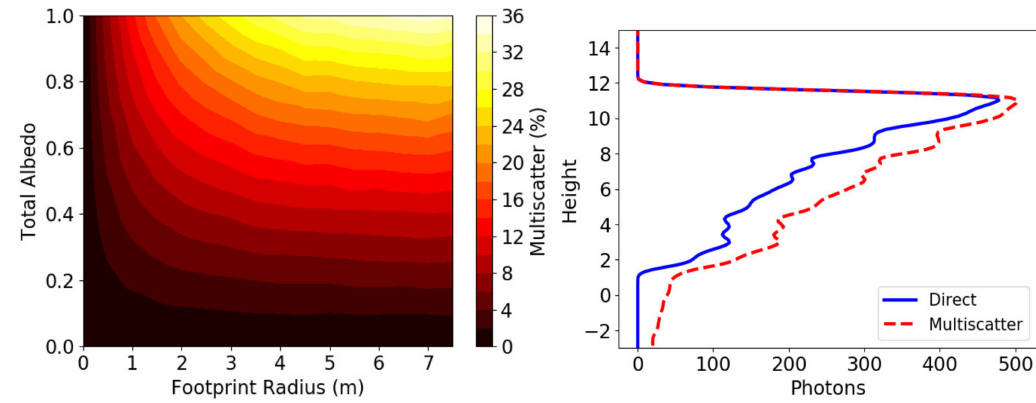
Figure 3. The left figure is the multiscatter contribution percentage as a function of lidar footprint radius and total albedo (reflectance + transmittance); the right figure is the waveform for the one albedo, 7.5 footprint